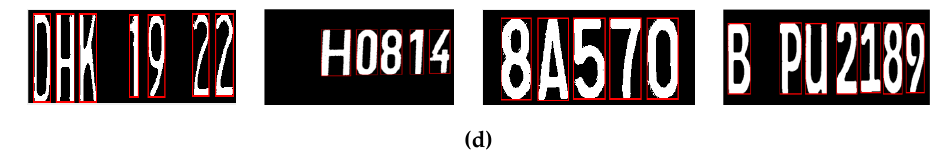
Figure 8. Required objects detection part based on character height estimation filter: (a) Angle detection, (b) Angle correction, (c) Border touched character separation, (d) Bounding boxes on required objects after removing a small object.